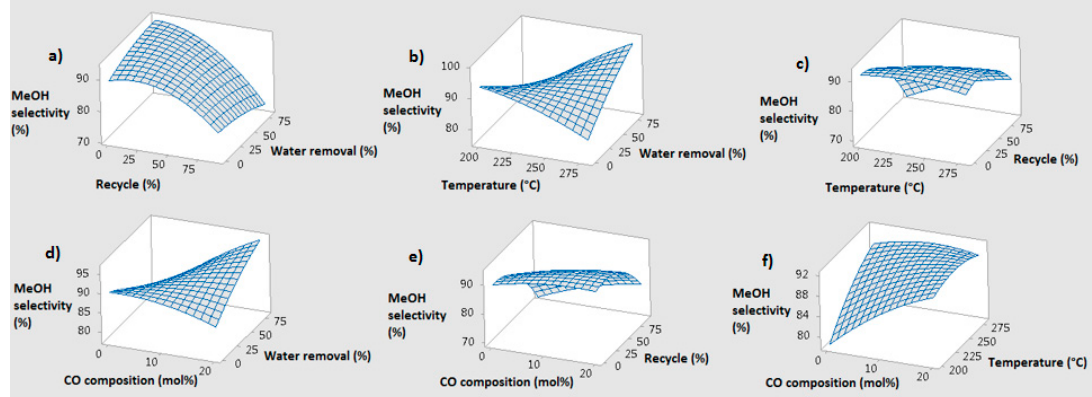
17 of 20 Figure 13. Methanol yield plots as function of analyzed factors (hold values: recycle 45%, temperature 240 °C, water removal 40%, CO composition in the feed 10 mol %): a) methanol yield as function of recycle and water removal; b) methanol yield as function of temperature and water removal; c) methanol yield as function of temperature and recycle; c) methanol yield as function of CO composition in the feed and water removal; e) methanol yield as function of CO composition in the feed and recycle; f) methanol yield as function of temperature and CO composition in the feed. Figure 14. Methanol production surface plots as function of analyzed factors (hold values: recycle